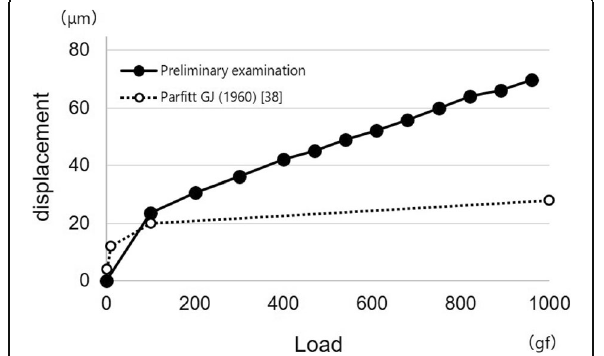
Fig. 5 Load displacement curve for the artificial periodontal ligament. Black circles indicate data from the preliminary examination of the artificial periodontal ligament in this study; white circles indicate data from Parfitt GJ (1960)